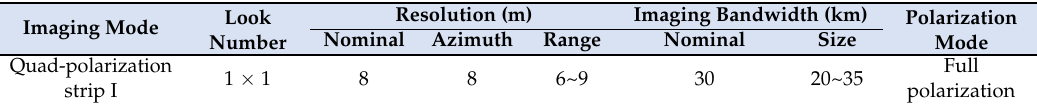
Table 1. Main technical specifications of QPSI imaging mode of the GF-3